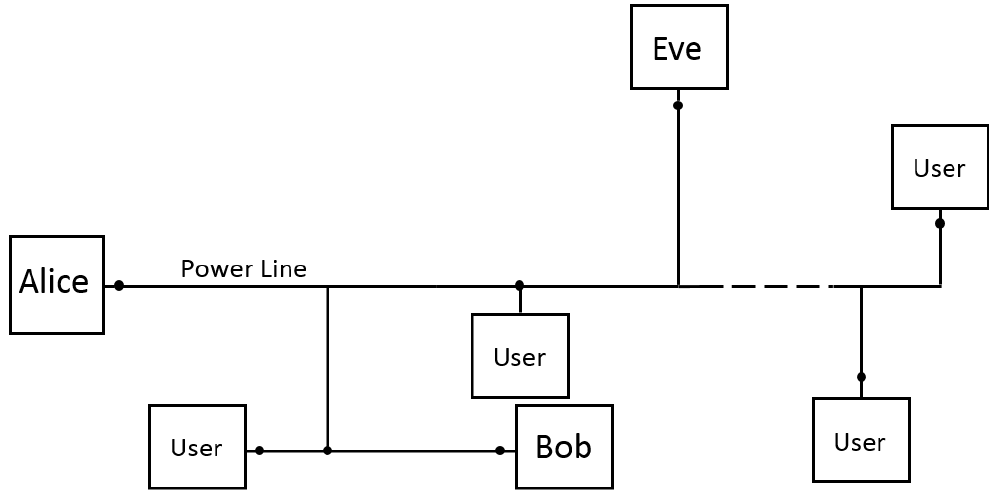
Figure 1. Essential sketch of a power line network, where we highlight the presence of the transmitting user (Alice), the intended receiver (Bob), and the eavesdropper